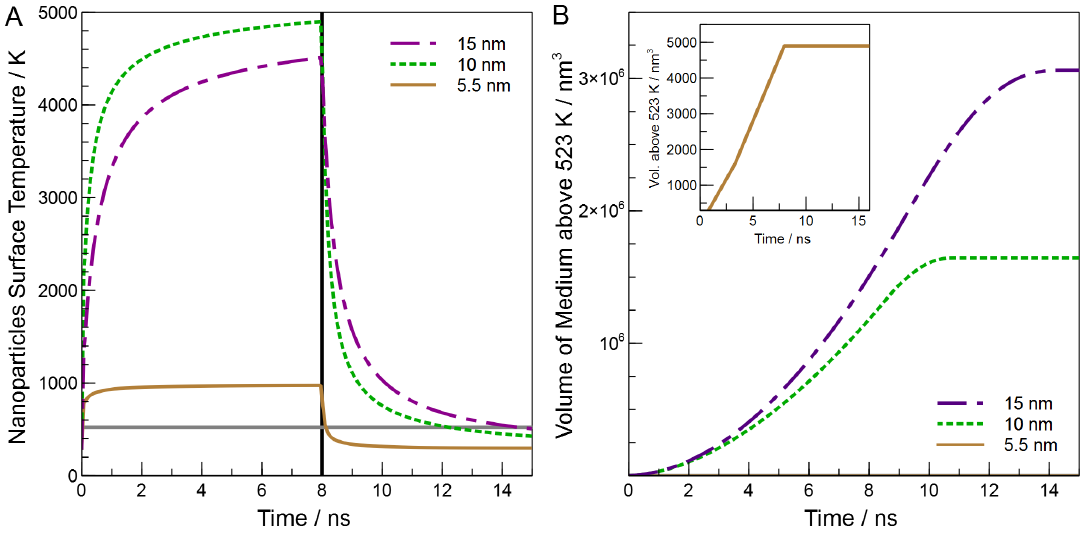
Figure 7. ( A ) Heating and cooling of the nanoparticles’ surface as simulated; ( B ) Reactive volume